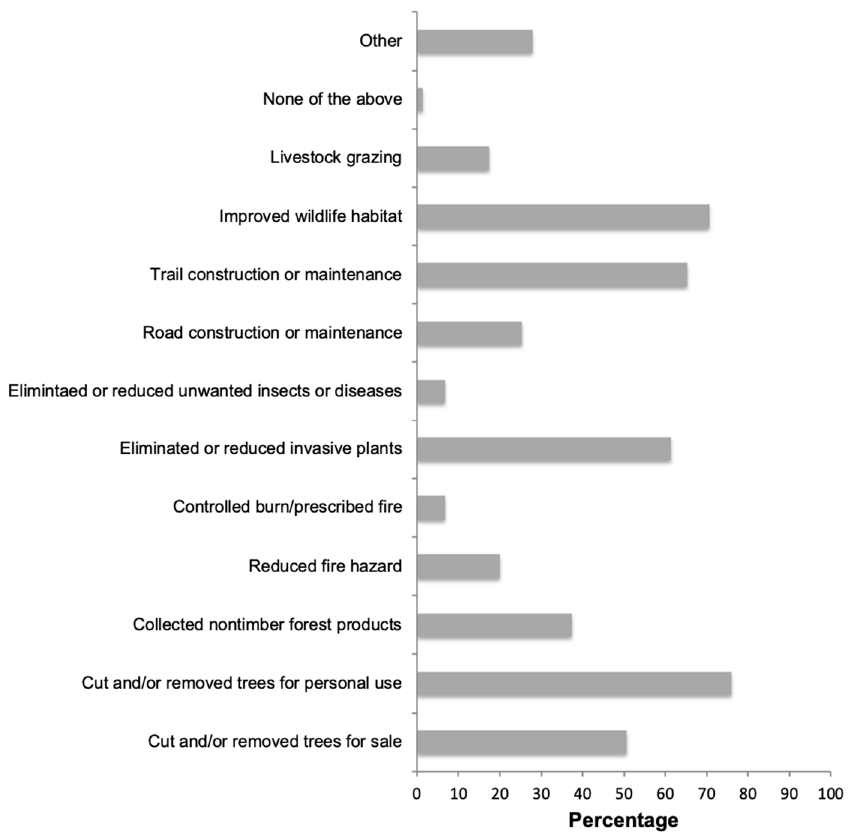
Figure 2. Activities from the past five years from all pre-survey respondents.